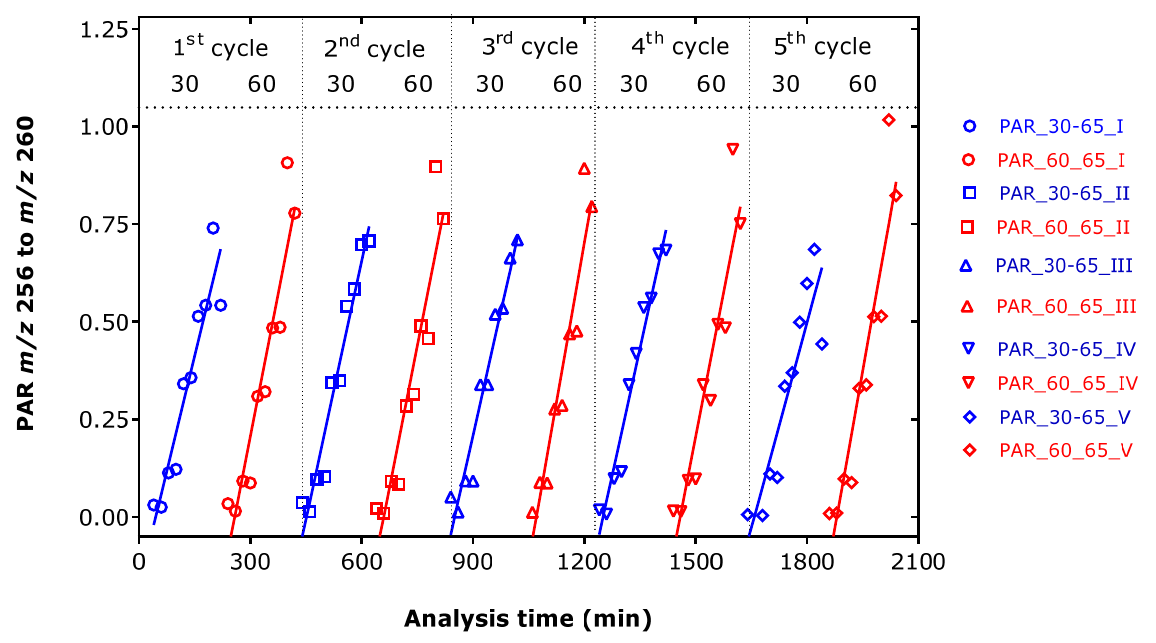
Figure 2. Peak area ratio (PAR) of m/z 256 for d 0 -HA to m/z 260 for d 4 -HA from duplicate GC-MS analyses in the SIM mode of standard mixtures of d 0 -HA (0, 70, 280, 420, 700 pmol) and d 4 -HA (900 pmol) derivatized with PFPA at 65 ◦ C (65) for 30 min (30) or 60 min (60). The derivatives were extracted with EA, and the samples were placed on the autosampler (about 19 ◦ C) and analyzed in five cycles (I, II, III, IV, V). Each sample required about 20 min of analysis, and the total analysis time was about 88 h. The GC program, OTP40, was used. Lines were observed by linear regression analysis. The r 2 values were: 0.8976 and 0.8938; 0.9527 and 0.8902; 0.9479 and 0.9093; 0.961 and 0.879; 0.8287 and 0.8821, respectively.